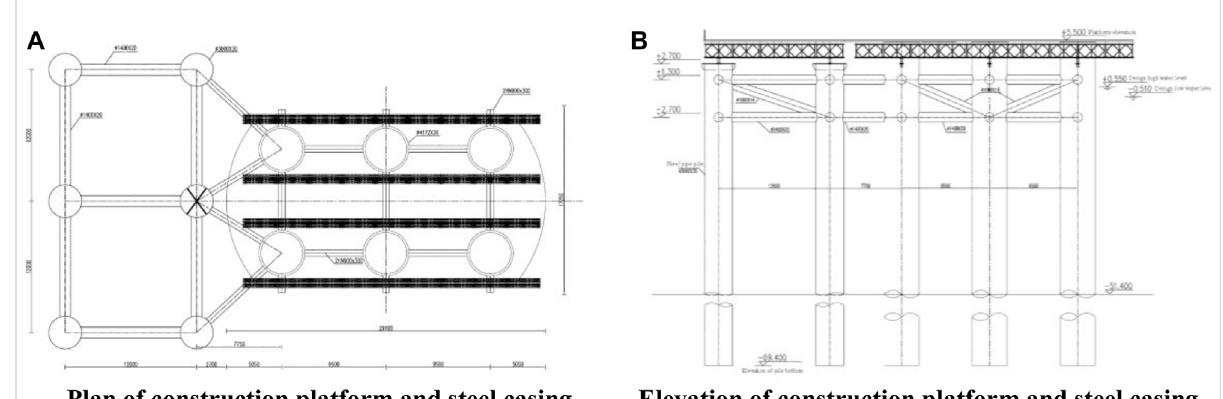
FIGURE 4 Geometric parameters of construction platform and steel casing. (A) Plan of construction platform and steel casing. (B) Elevation of construction platform and steel casing.